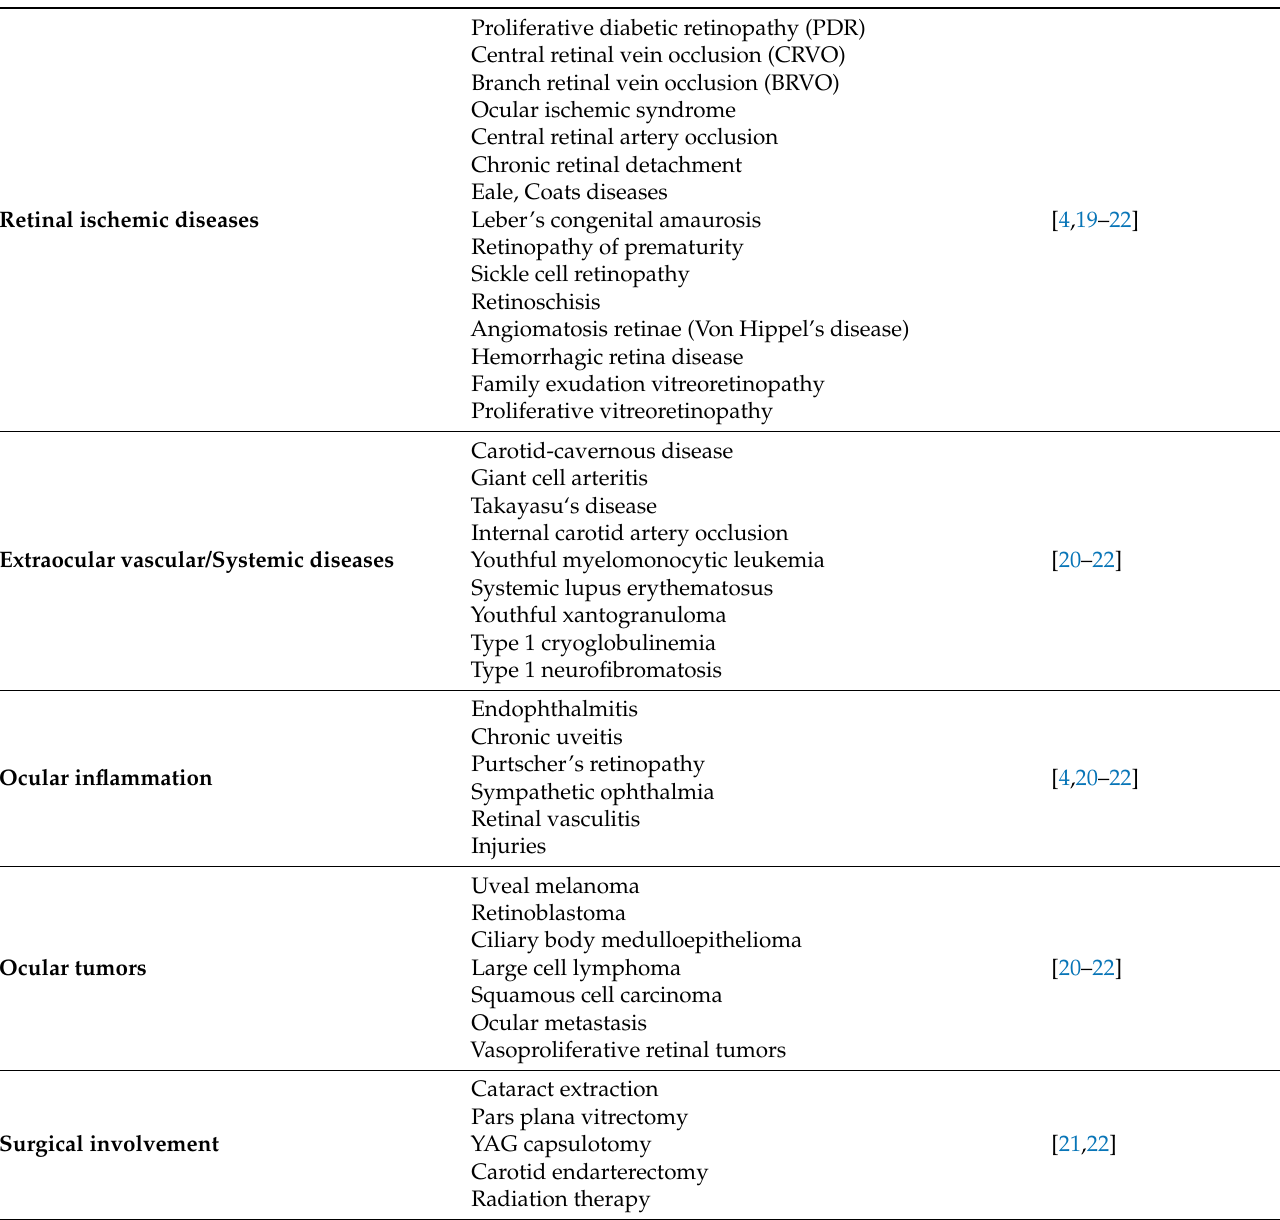
Table 1. Ocular and extraocular conditions predisposed to anterior segment